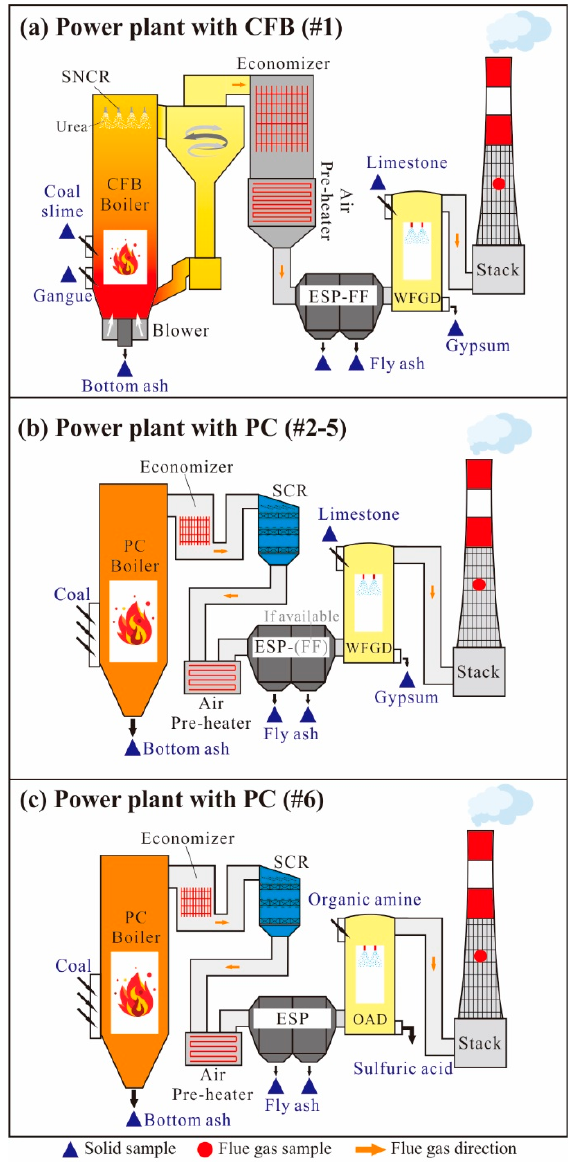
Figure 2. Sampling sites in the six CFPPs with ( a ) CFB and ( b , c ) PC.